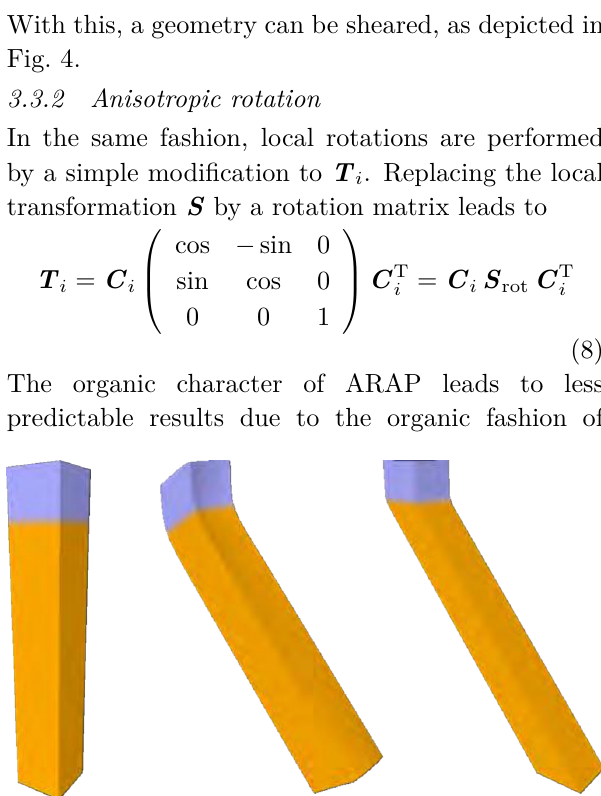
Fig. 3 Top: instead of aligning the currently deformed vertex fan (green) to the reference mesh’s fan (blue), we scale the neighborhood ˆ v i by the directed scaling T i (red). Bottom: the triangle case for the parameterization is shown accordingly.